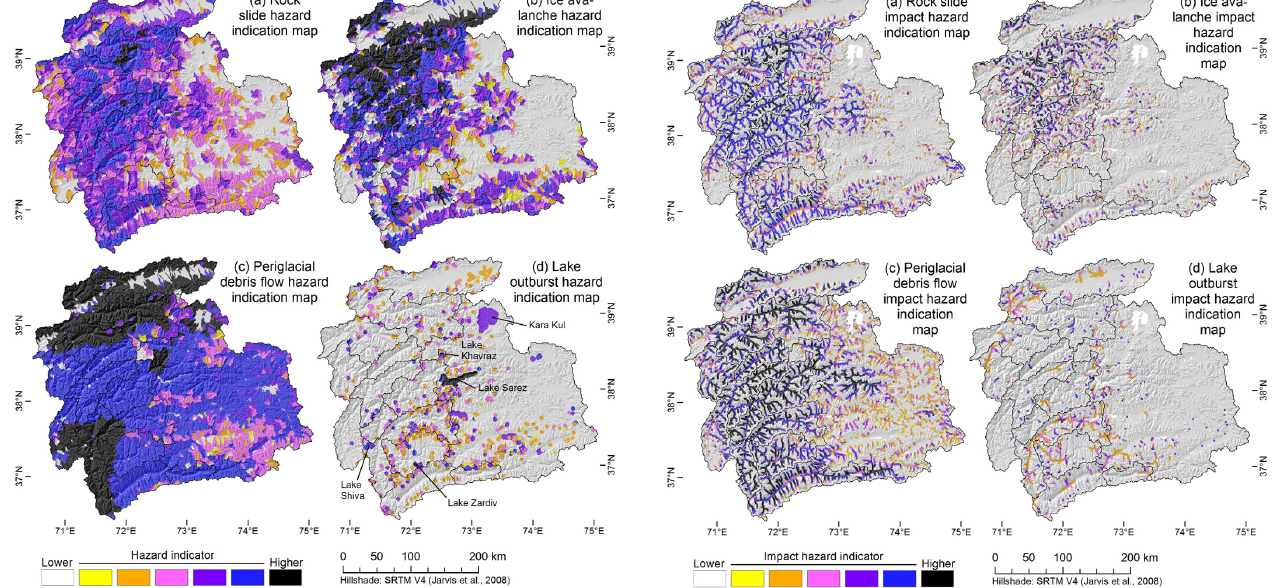
Fig. 9. Impact hazard indicator for each process, (a) rock slides, (b) ice avalanches, (c) periglacial debris flows, and (d) lake outburst floods. For clarity, only the indicators along the main flow lines are